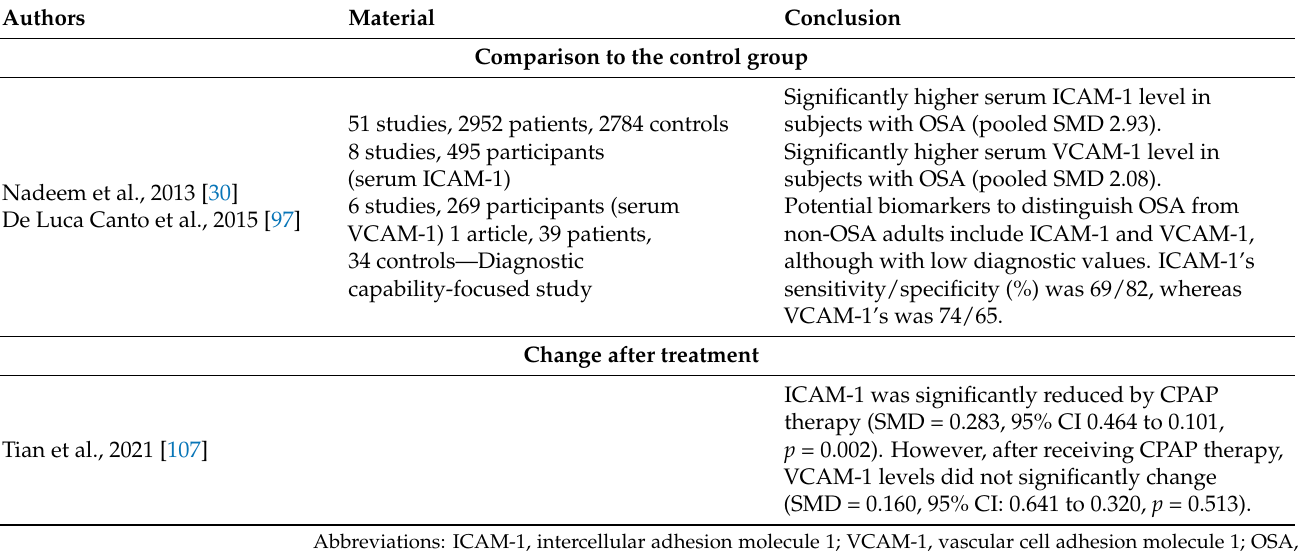
Table 7. Meta-analyses of ICAM-1 and VCAM-1 studies in OSA adults.